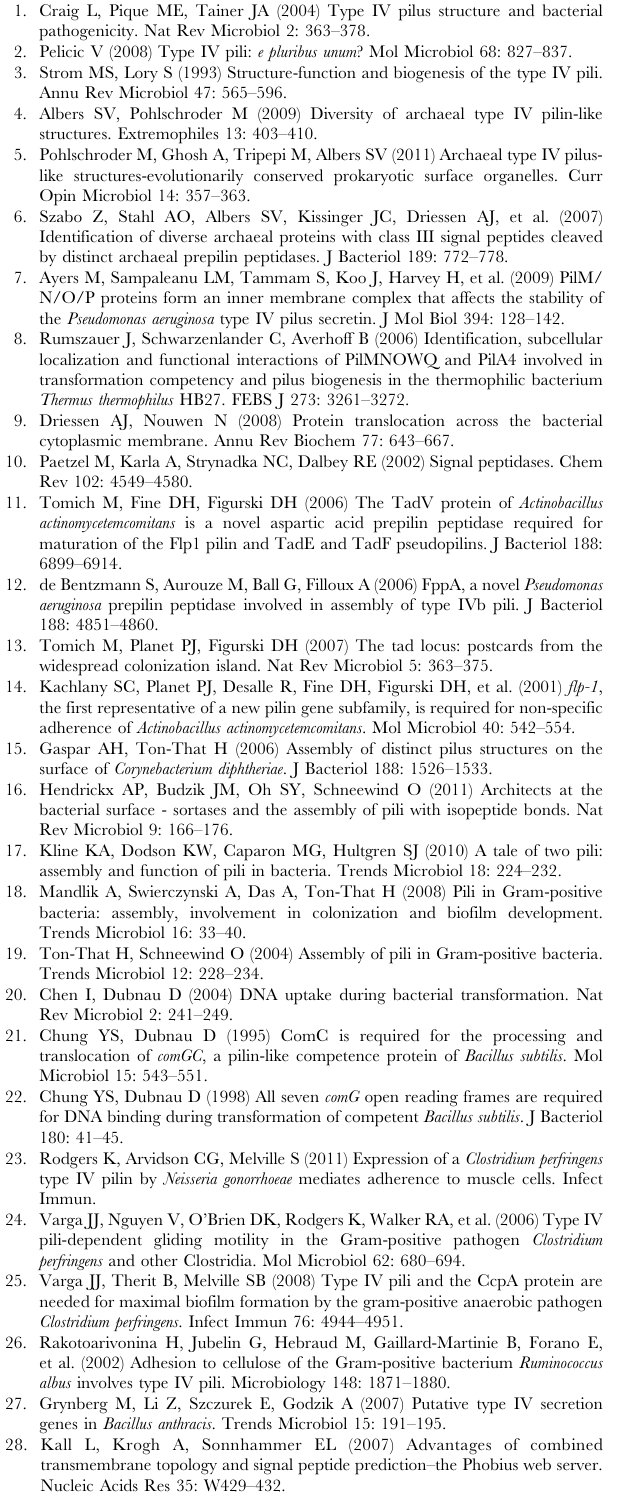
Table S3 Features of false negatives and false positives from PilFind